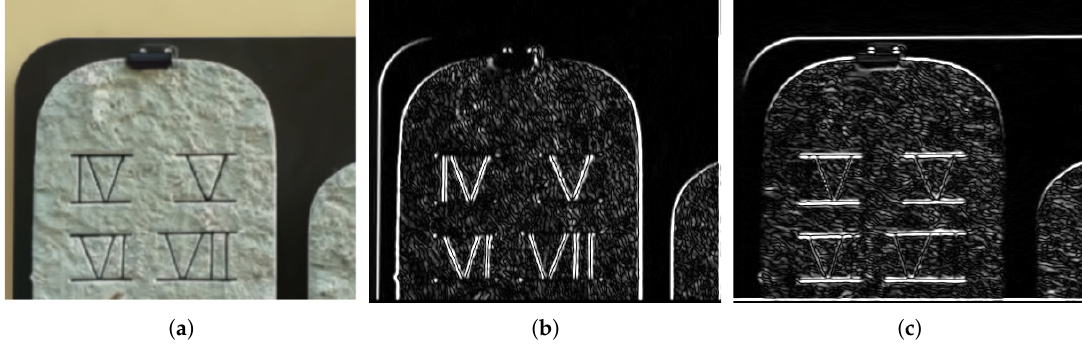
Figure 1. Input image and its horizontal and vertical gradients in absolute values. ( a ) Input; ( b ) absolute value of the horizontal gradient; ( c ) absolute value of the vertical gradient.